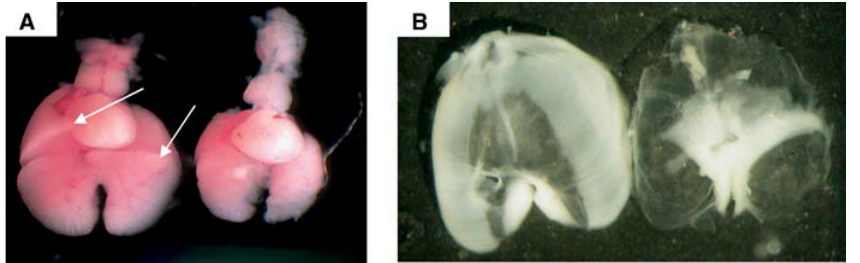
Figure 1. Abnormal Pulmonary and Diaphragmatic Development in the lil Mouse (A) The mutant hypoplastic lung (right) lacks the development of the accessory lobe and the anterior portion of the right middle lobe (marked with arrows on the control sample on the left). (B) Whole diaphragms show a lack of normal muscularization in the posterolateral regions and the peripheral regions of the mutant diaphragm (control on left and lil diaphragm on the right). DOI: 10.1371/journal.pgen.0010010.g001